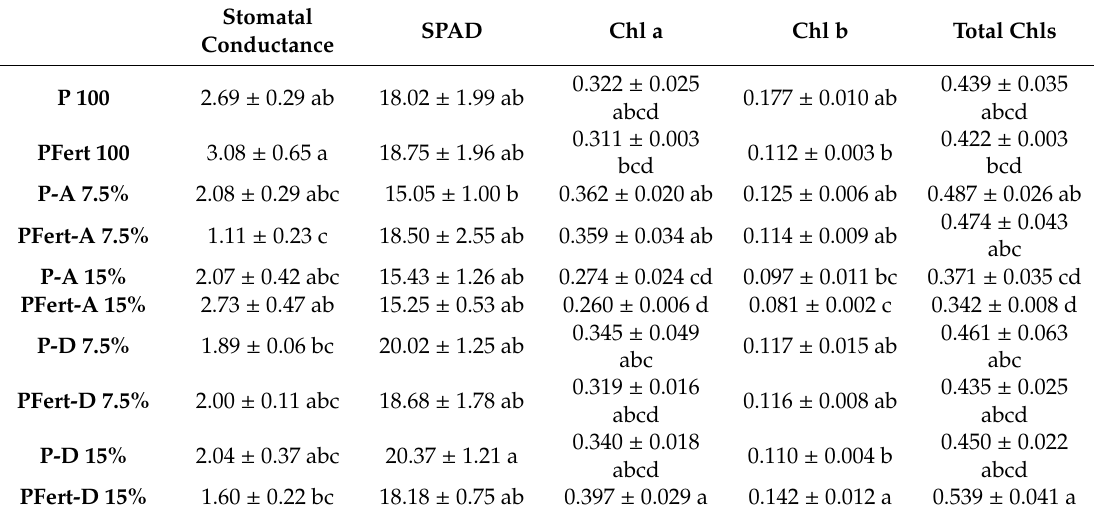
Table 5. E ff ects of peat (P 100) with di ff erent biochar types (A, D) and ratio (7.5%, 15%) and mineral doses (with standard or with additional Fertilizers-Fert.) on leaf chlorophyll content (SPAD units), leaf stomatal conductance (cm s − 1 ) and chlorophylls (Chl a, Chl b, total Chls) content (mg g − 1 ). Values ( n = 6) in columns followed by the same letter are not significantly different, p < 0.05.